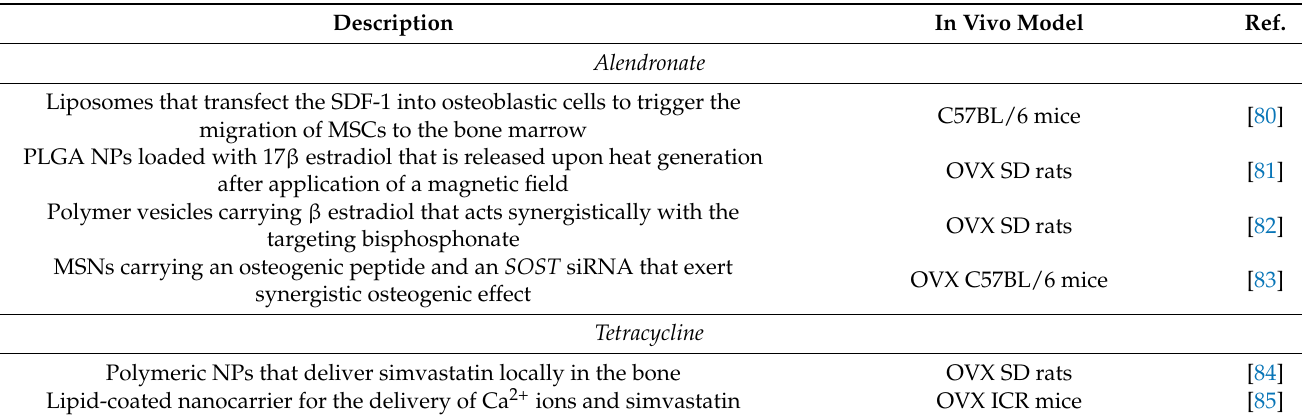
Table 2. Summary of the research articles exposed in Section 3 classified according to the targeting agent